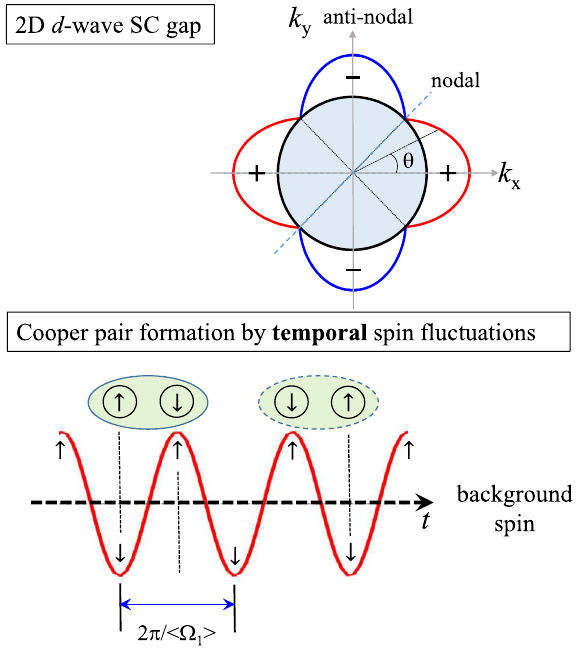
Figure 3. High-transition-temperature superconductors, cuprates. (Upper) Schematic of the d-wave superconducting (SC) gap. (Lower) Cooper pair formation by the average spin fluctuations. Here, ↑ and ↓ indicate the up and down excess spins above the background spin,